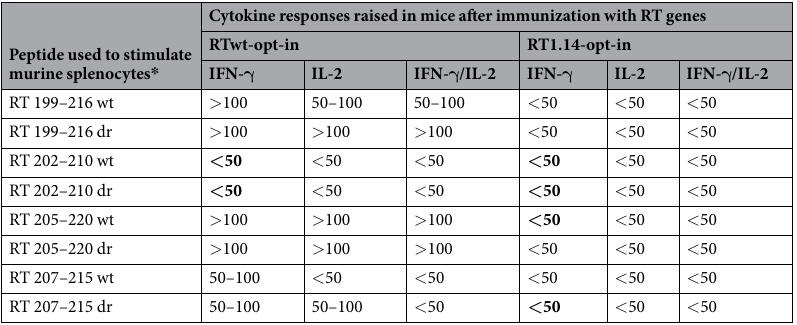
Table 1. Immune recognition by RTwt and RT1.14 gene-immunized mice of the peptides encompassing regions of drug resistance conferring mutations detected by IFN- γ /IL-2 Fluorospot. Each entry represents the results of two or more IFN- γ /IL-2 Fluorospot tests performed after single or repeated (double-prime and prime- boost) RT gene immunizations: > 100 – more than 100, 50–100–50 to 100, < 50 - less than 50 spot-forming cells per million stimulated lymphocytes (splenocytes). * Peptide sequences are given in Table 1. Results of Fluorospot tests that are discordant with the results of the multi-parametric FACS assays (Fig. 9) are in